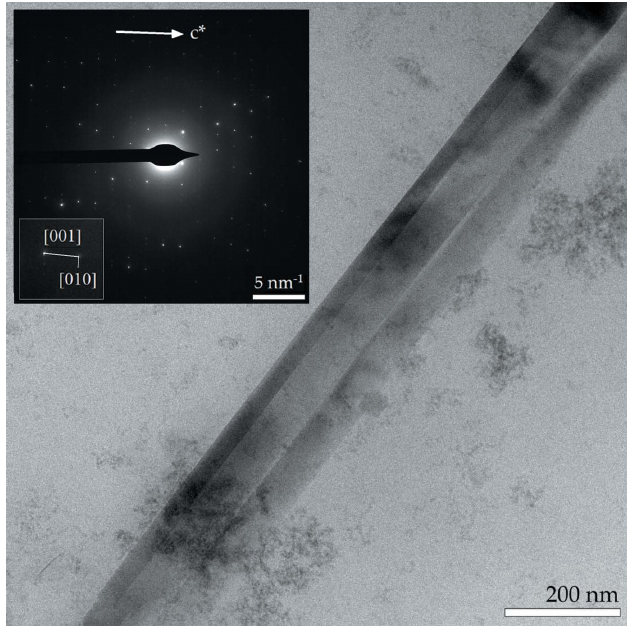
Figure 2 ATEM image of a highly crystalline amosite fibre after long permanence in the patient’s lung. At the top left, a SAED pattern of the core of the fibre is shown. SAED shows the typical diffraction pattern of a crystalline material. The d spacings (A˚ ) and the angle determined from the pattern are: 18.3 A˚ along [010], 5.3 A˚ along [001] and (cid:8) = 90 (cid:5) . The calculated cell parameters are consistent with the data reported by Pollastri et al. (2017) and Fischer